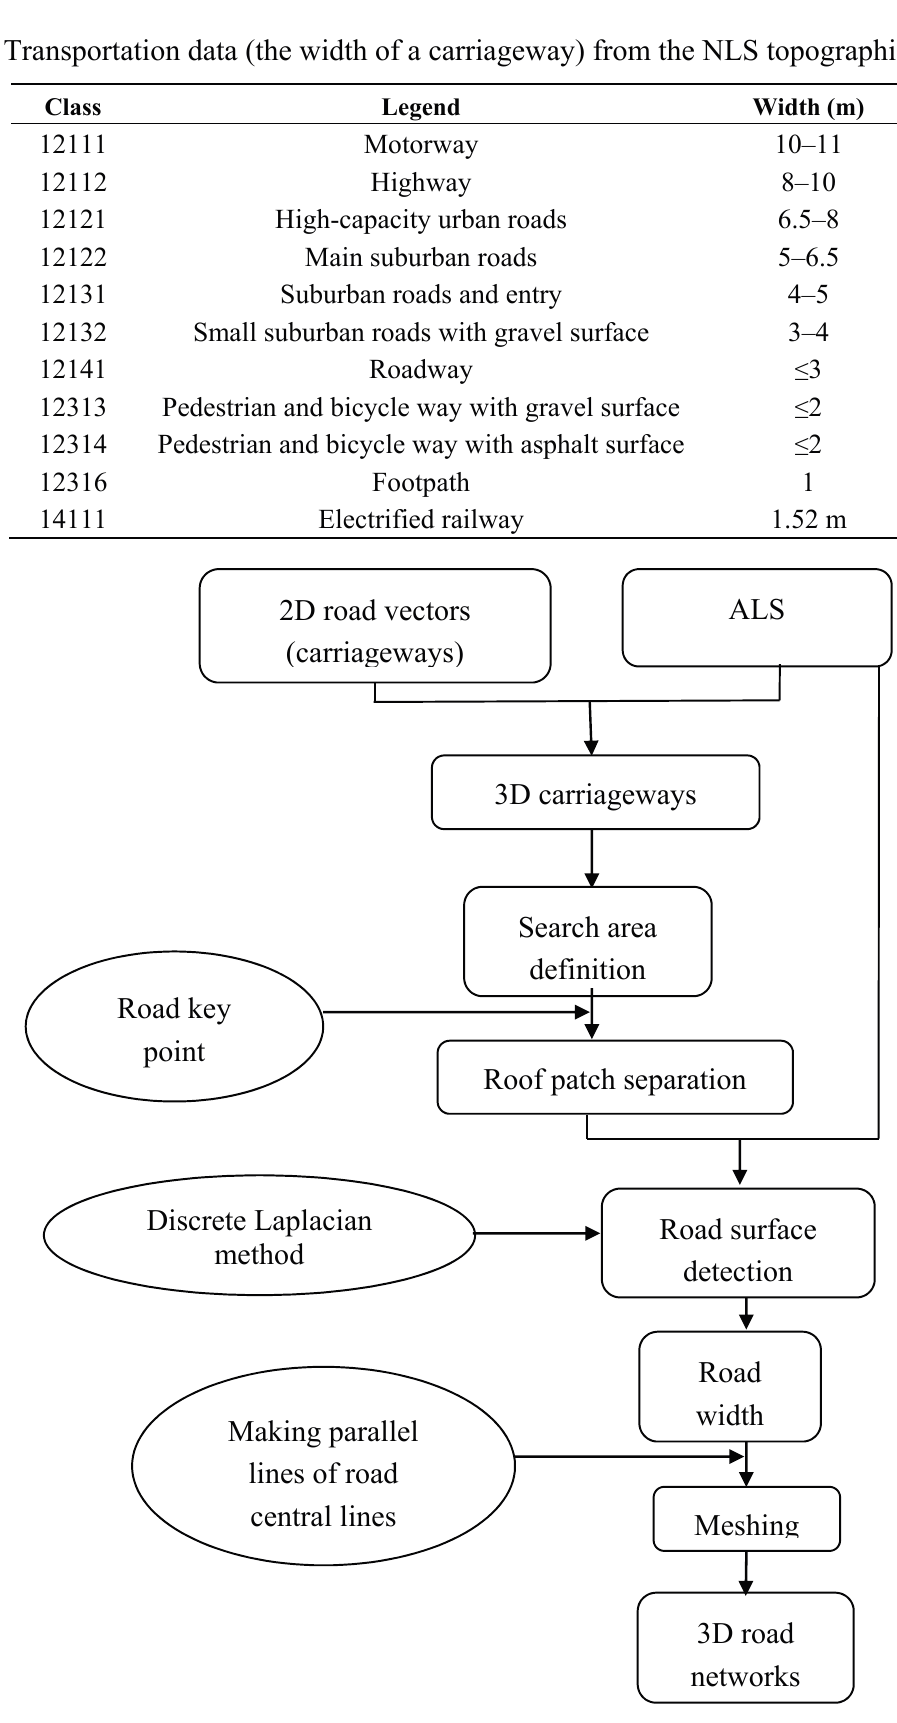
Figure 11. Procedure of 3D road network